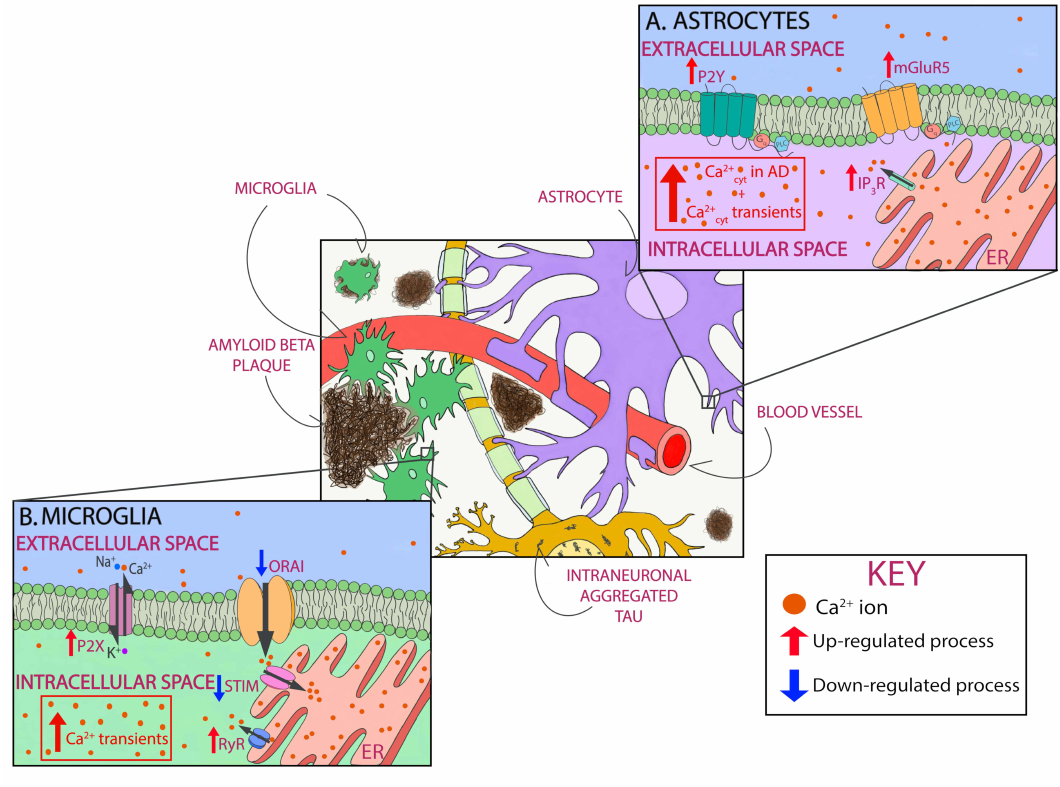
Figure 2. Astrocytic and microglial Ca 2 + as a therapeutic target in AD. Schematic of glial Ca 2 + cells dysregulation in the presence of AD pathology. In astrocytes, P2Y purinoceptors and glutamate metabotropic receptors mGluR5, when activated, cause Ca 2 + increase by releasing Ca 2 + from intracellular stores. As shown in red, all three receptors are upregulated in AD. In addition, cytosolic Ca 2 + levels are increased in astrocytes, and they exhibit Ca 2 + transients ( A ). In microglia, P2X receptors are upregulated in AD, thus leading to Ca 2 + dysregulation. SOCE, with involves STIM and Orai, is also responsible for Ca 2 + influx, specifically into the lumen of the endoplasmic reticulum (ER). This pathway is downregulated in AD (shown in blue). RyRs mediate Ca 2 + e ffl ux from the ER, a process that is upregulated in AD. Microglia also show Ca 2 + dysregulation by showing cytosolic Ca 2 + transients ( B